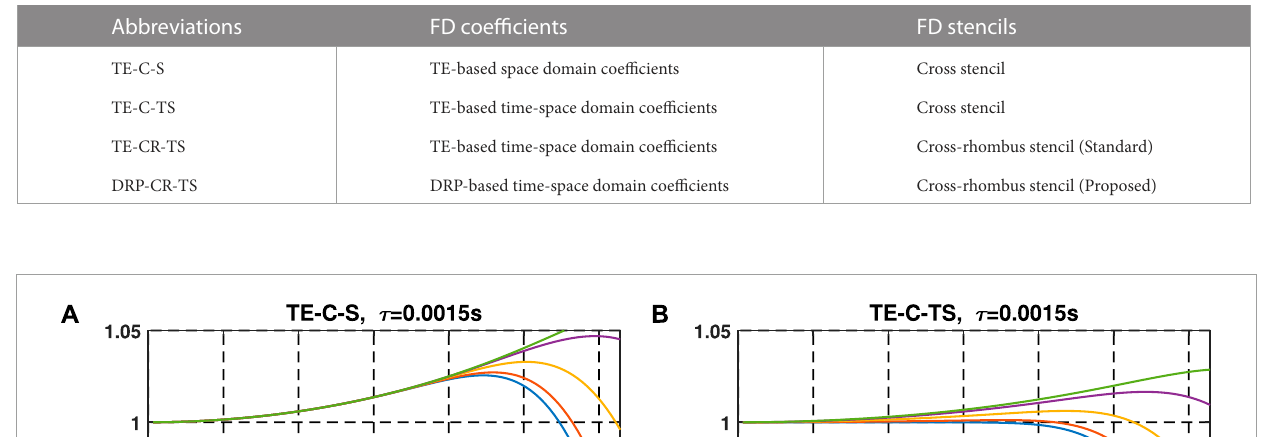
TABLE1 AbbreviationtableofdifferentFDmethodsusedfordispersionanalyses.